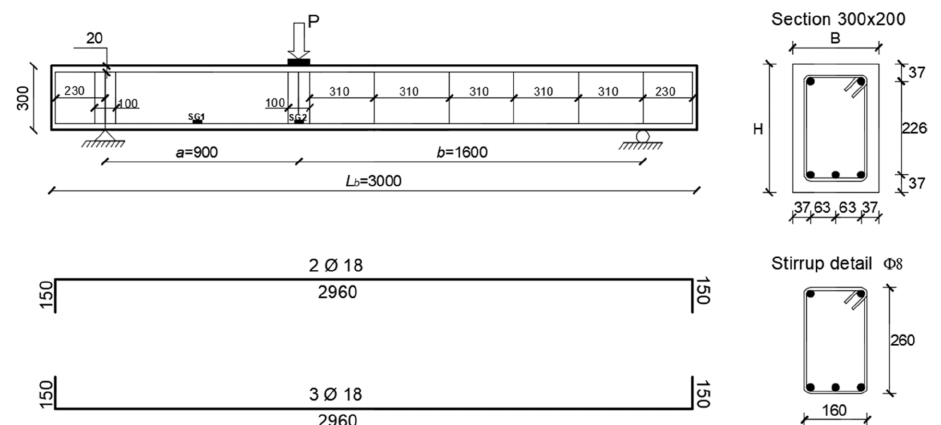
Figure 3. Geometry configuration of the